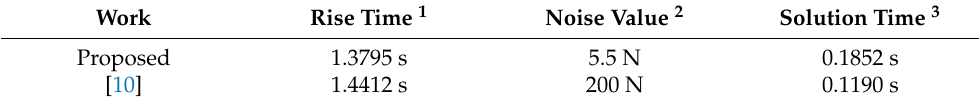
Table 2. Effect comparison of the virtual force